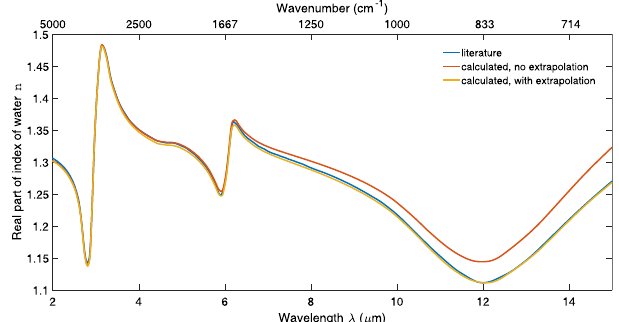
Figure 4. The real part of refractive index of water reported in literature compared with the real index calculated from mid-infrared measurement. The yellow and red traces show the responses with and without low frequency extrapolation of the k spectrum used in the